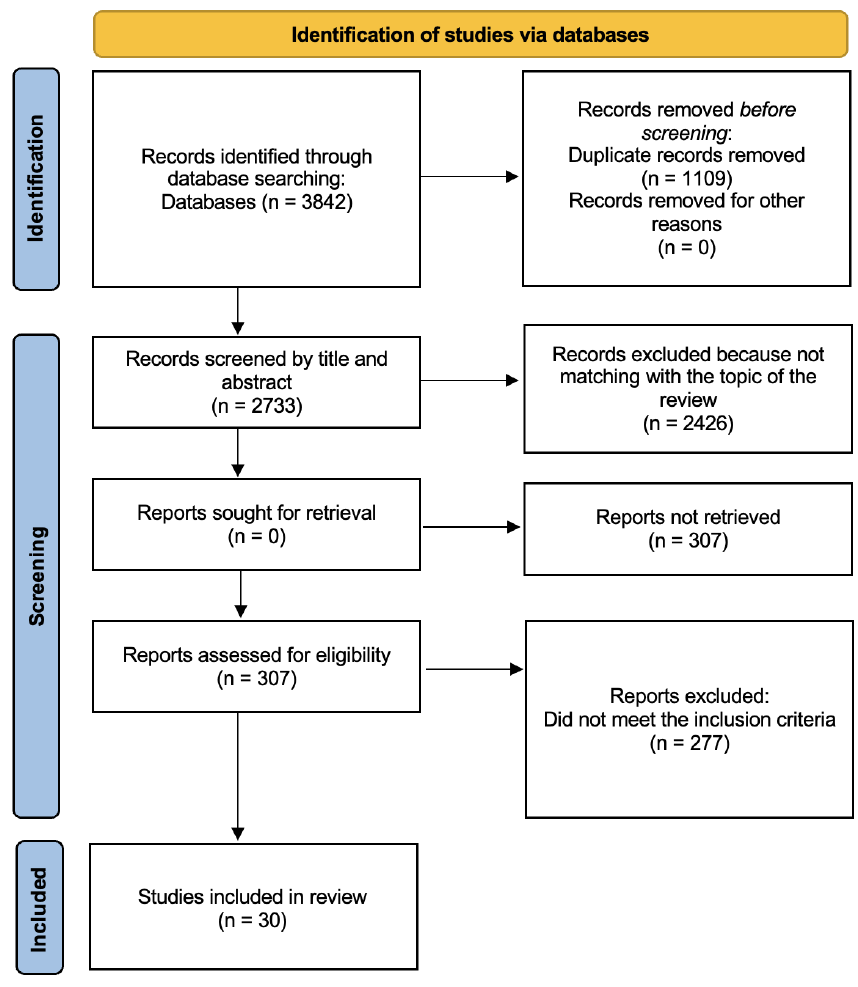
Figure 1. PRISMA (2020) Flow Diagram.